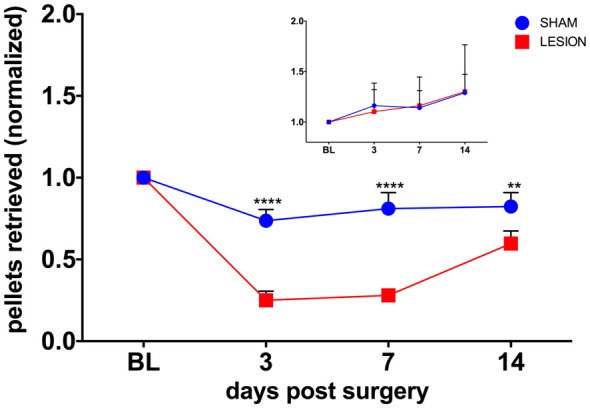
The dCST lesion impaired the performance of the preferred paw (PP), but not the non-preferred paw (NPP), in the Montoya staircase test. The performance of the PP of animals from the lesion group was lower than the sham group in all time points. However, the performance of the NPP was similar between the groups (inset). Values were normalized to baseline (BL) levels. ****p < 0.0001, **p = 0.0024. Two-way analysis of variance (ANOVA), repeated measures, Sidak’s multiple comparisons test. Error bars represent mean ± SEM.